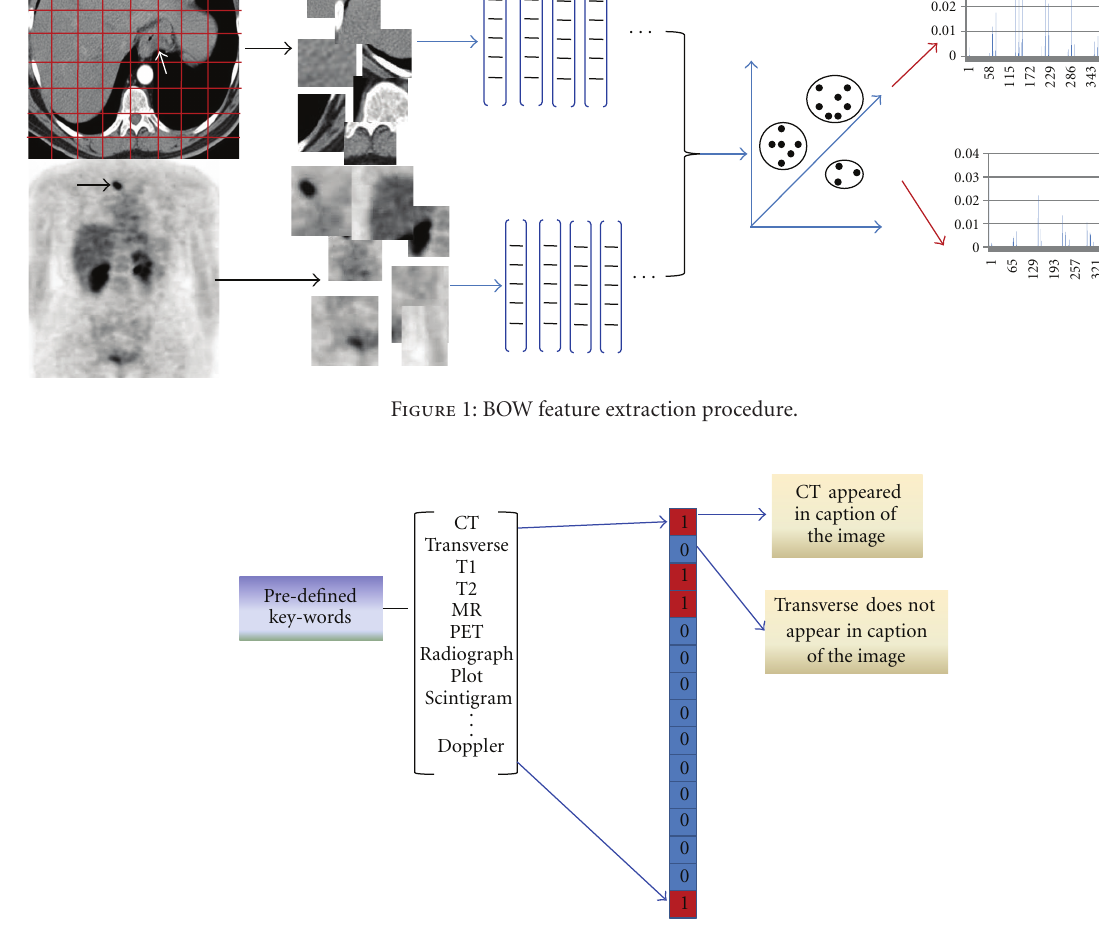
Figure 2: Textual feature extraction